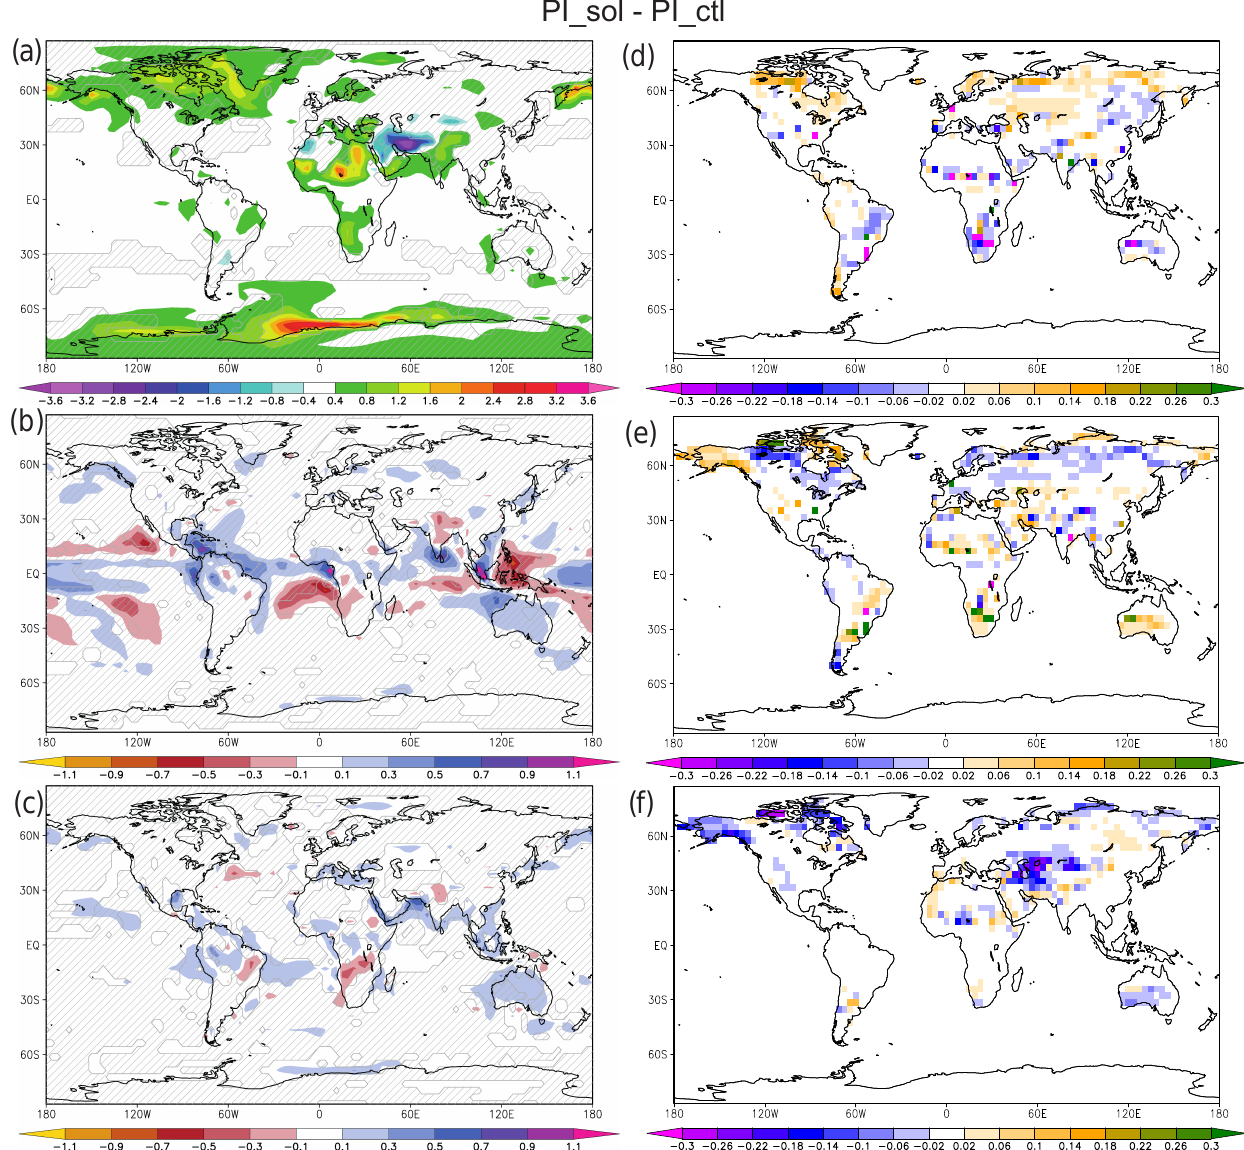
Figure 3. Differences in 100-year annual mean of the preindustrial climate state with dynamic soils and fixed soil characteristics (PI_sol – PI_ctl) included for (a) surface air temperature in degrees Celsius, (b) total precipitation in millimetres per day, (c) evaporation in kilograms per square metre per day, (d) forest fraction, (e) grass fraction, and (f) desert fraction. Hatched areas identify non-significant values, calculated by means of a Student t test with 0.05 levels of